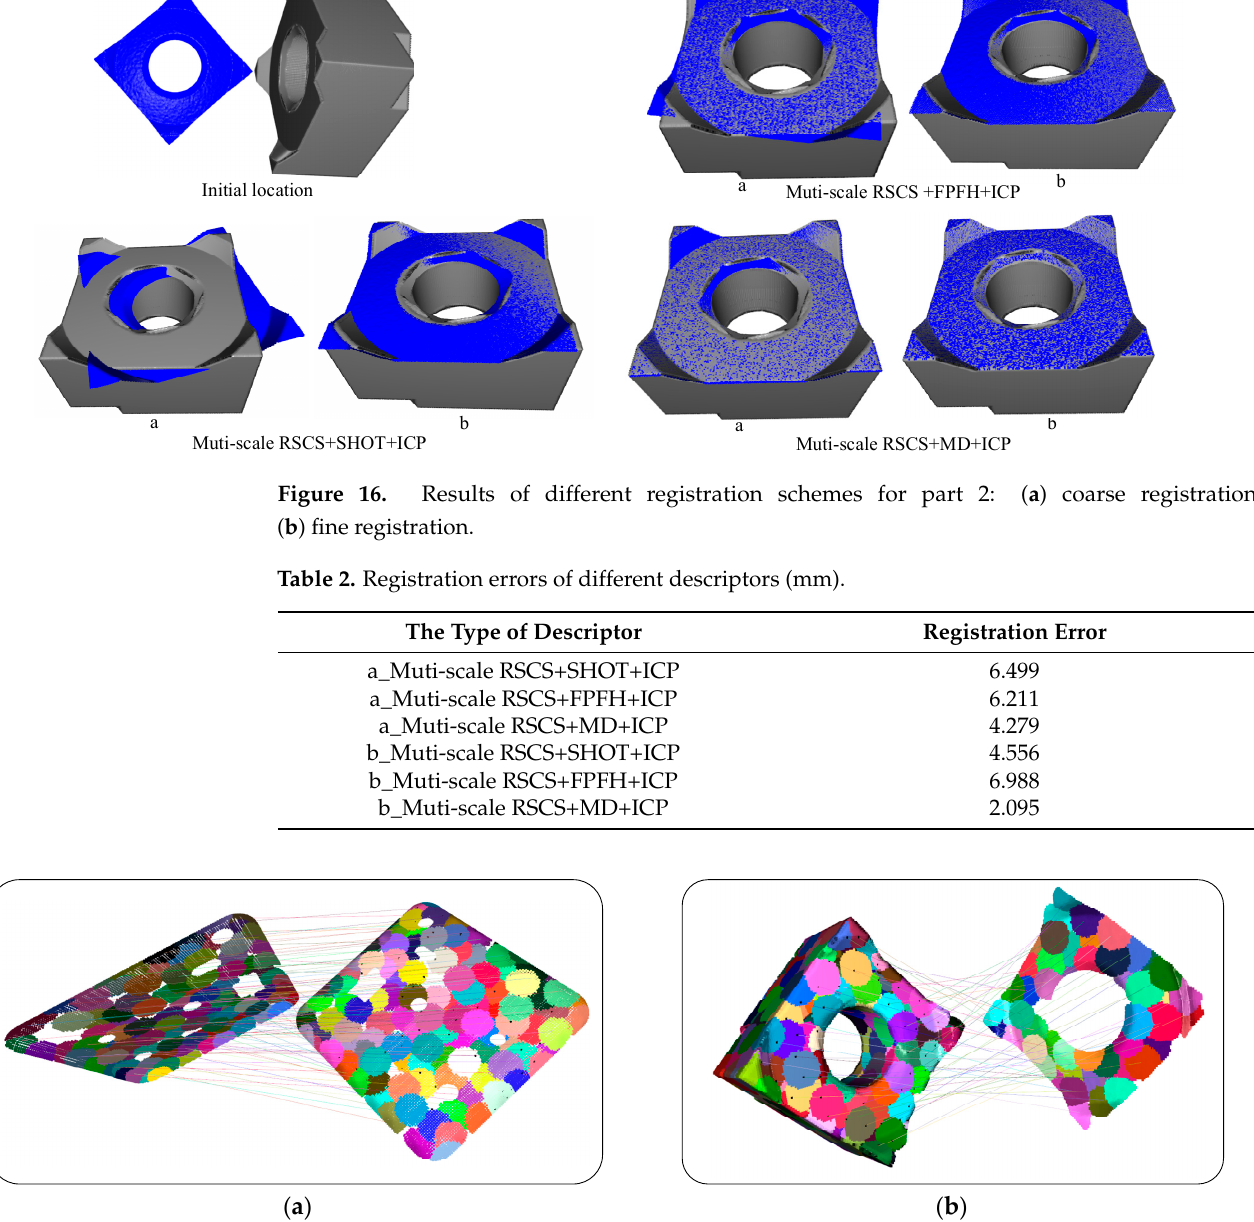
Figure 15. Results of different registration schemes for part 1: ( a ) coarse registration; ( b ) fine regis- tration.